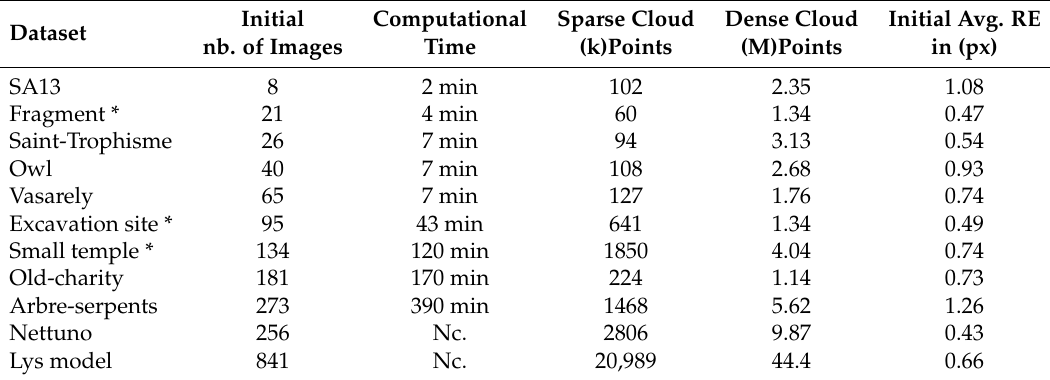
Table 1. Composition and results of initial data sets extracted from the global